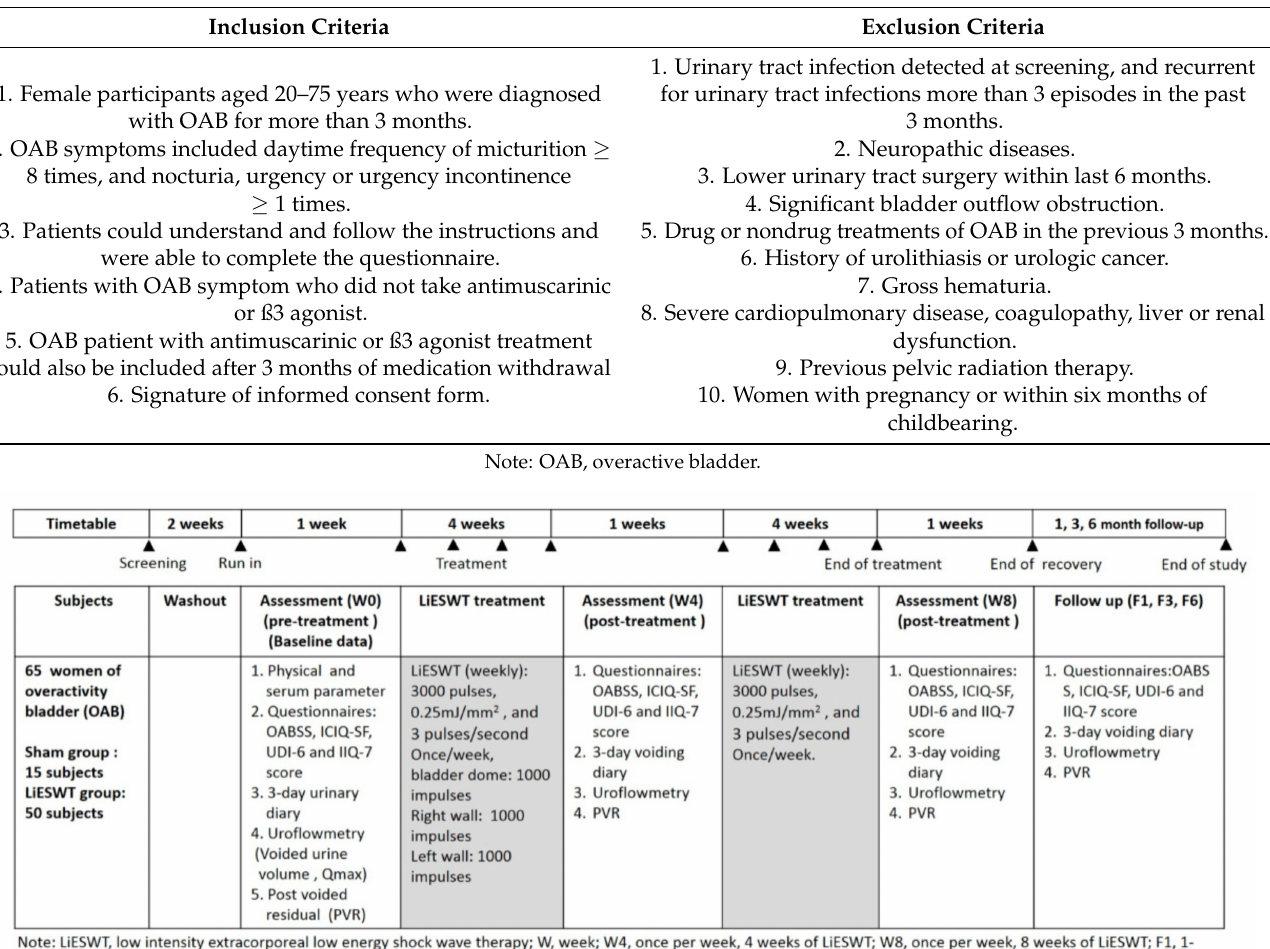
Table 1. Inclusion and exclusion criteria.